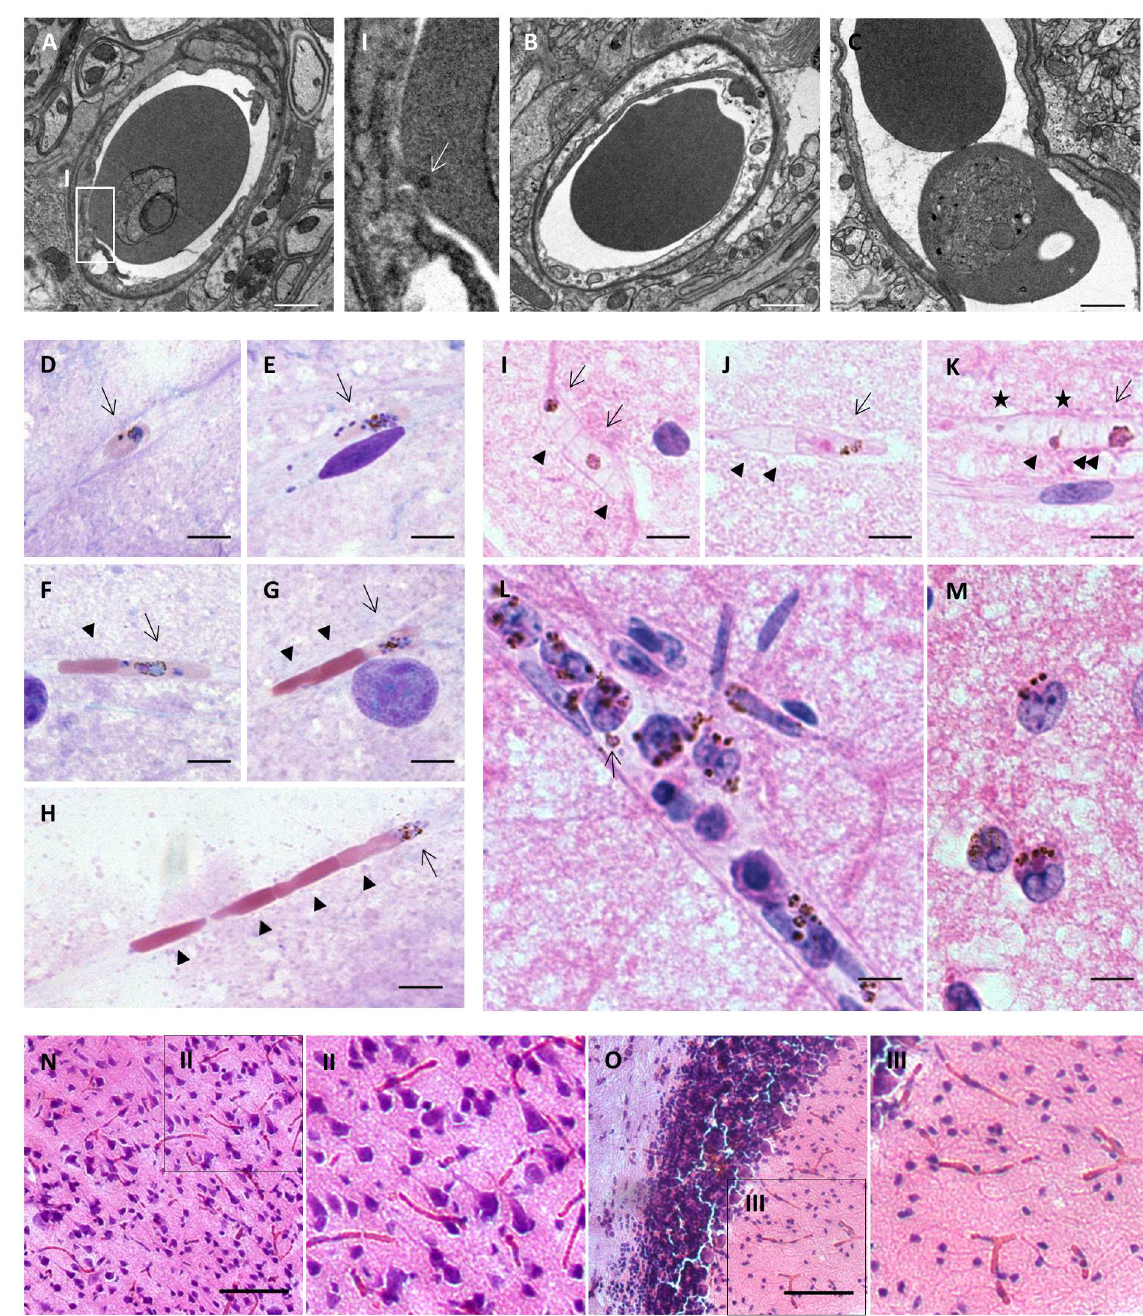
Fig 3. A single, pRBC is sufficient to occlude a capillary in the brains of mice infected with Pb ANKA. C57BL/6mice were infected with 1x10 4 Pb ANKA GFP pRBCs and euthanisedupon developing ECM (d7 p.i.) Transcardially perfused brainswere dissected out and processedfor TEM (Figs A-C) (n = 3), smeared for cytological examination (Figs D-M) (n = 5) or processedfor histologicalinvestigation (Figs N-O) (n = 8). Electron micrographsof: (A) a sequestered pRBC in the cross-section of a capillary, (i) with the adjacent digitallymagnifiedpanel highlightingan electron-dense spot ( " ) on the infected erythrocyte surface, proximalto the endothelium. (B) An uninfected,highly deformedRBC squeezingthrough a capillary. (C) An uninfectedRBC trapped behinda sequesteredpRBC in a capillarylongitudinal-section. Brain smears stainedvia Quik-Diff depicting:a (D) mid to late-stage trophozoite( " ) and a (E) late-stage schizont ( " ) sequestered within capillaries.Capillaries with (F) 1, (G) 2 and (H) 4 uninfected RBCs ( ▲ ) trapped behinda single, mature pRBC ( " ). H&E stained brain smears demonstrating: (I) uninfectederythrocytes( ▲ ), trapped behindcytoadherent pigmented pRBCs ( " ), deformed by the narrow capillarylumen. (J) A pigmented, mid-stagetrophozoite ( " ) sequestered within a capillary entraps two uninfectedRBCs ( ▲ ). (K) A sequestered schizont ( " ) occludesa capillary, with a